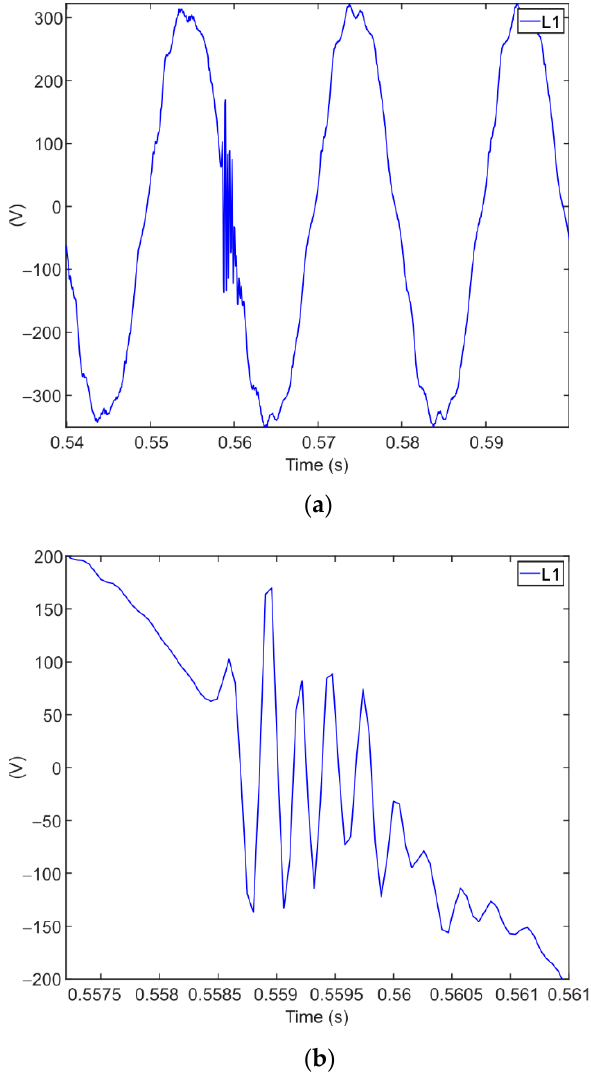
Figure 2. High-frequency damped sinusoidal fast transient overvoltage with oscillation frequency of 4 kHz: ( a ) signal with the disturbance; ( b ) expanded